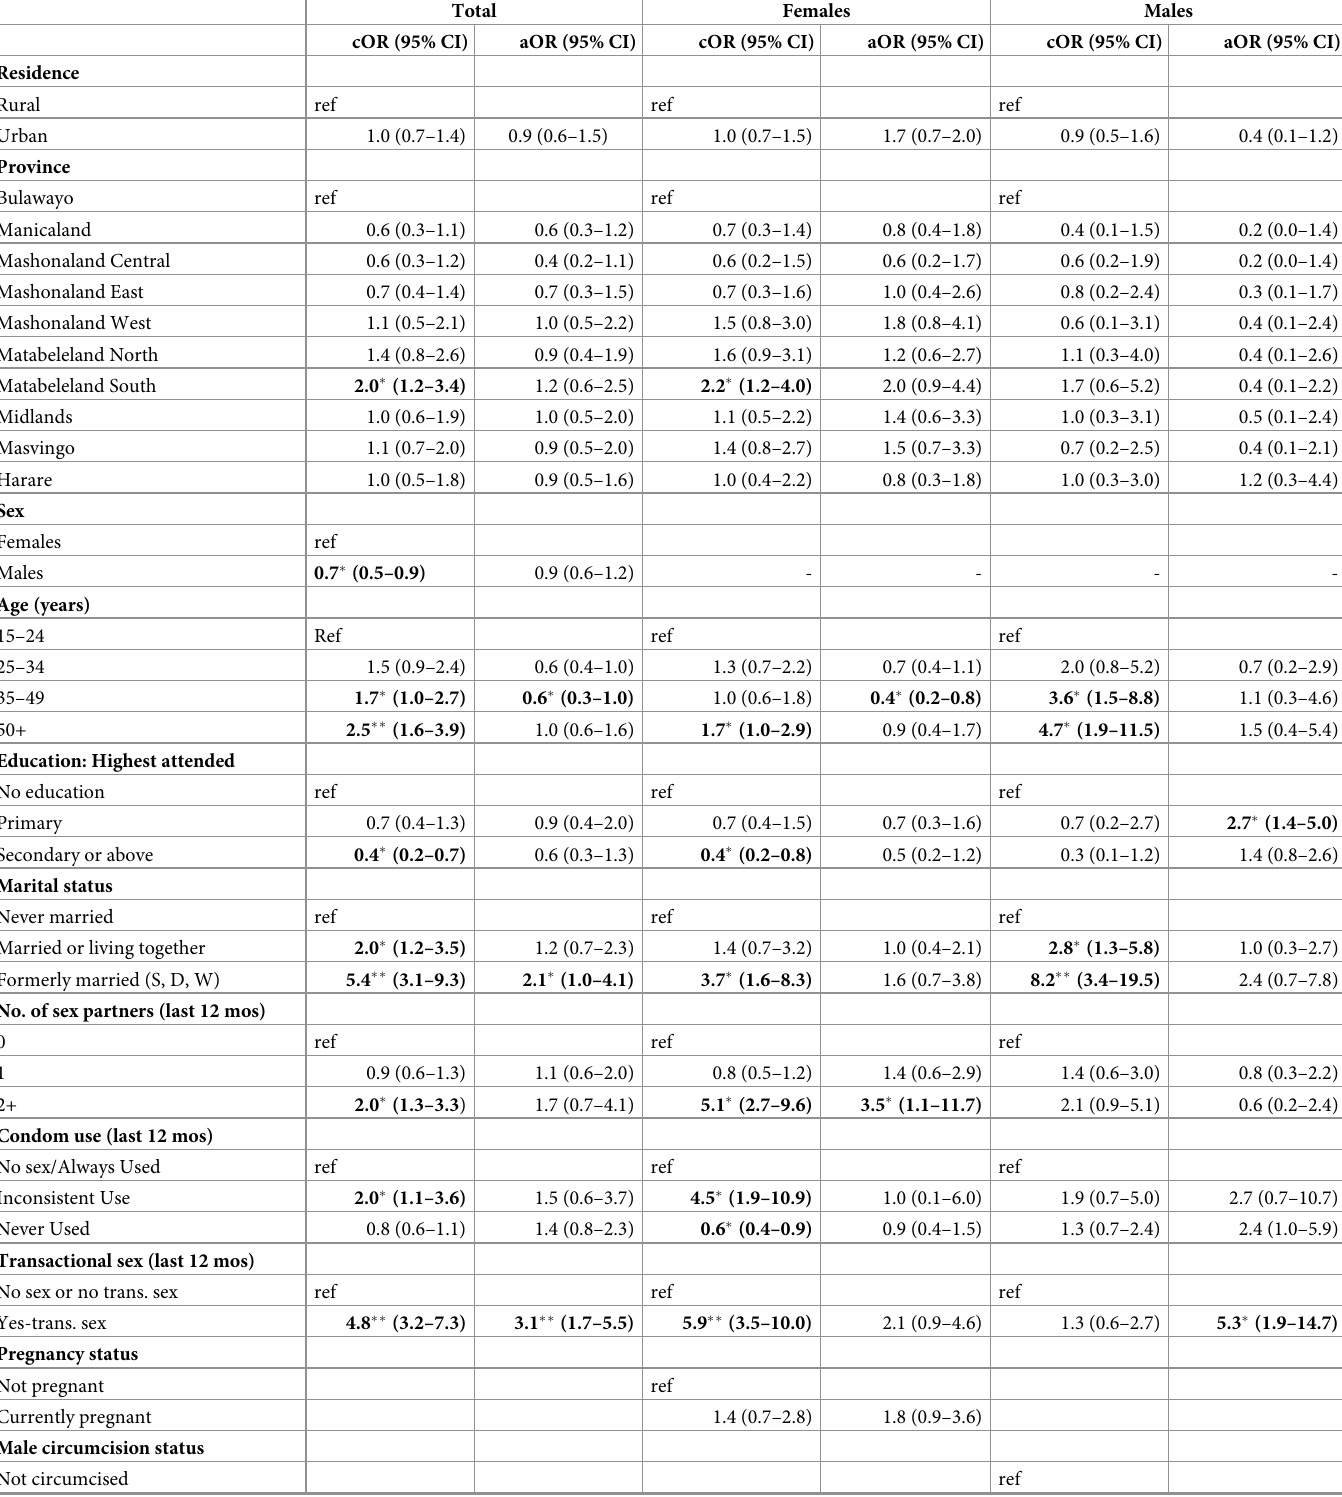
Table 2. Crude and adjusted odds ratios of co-variates of active syphilis by sex, ages 15+; ZIMPHIA